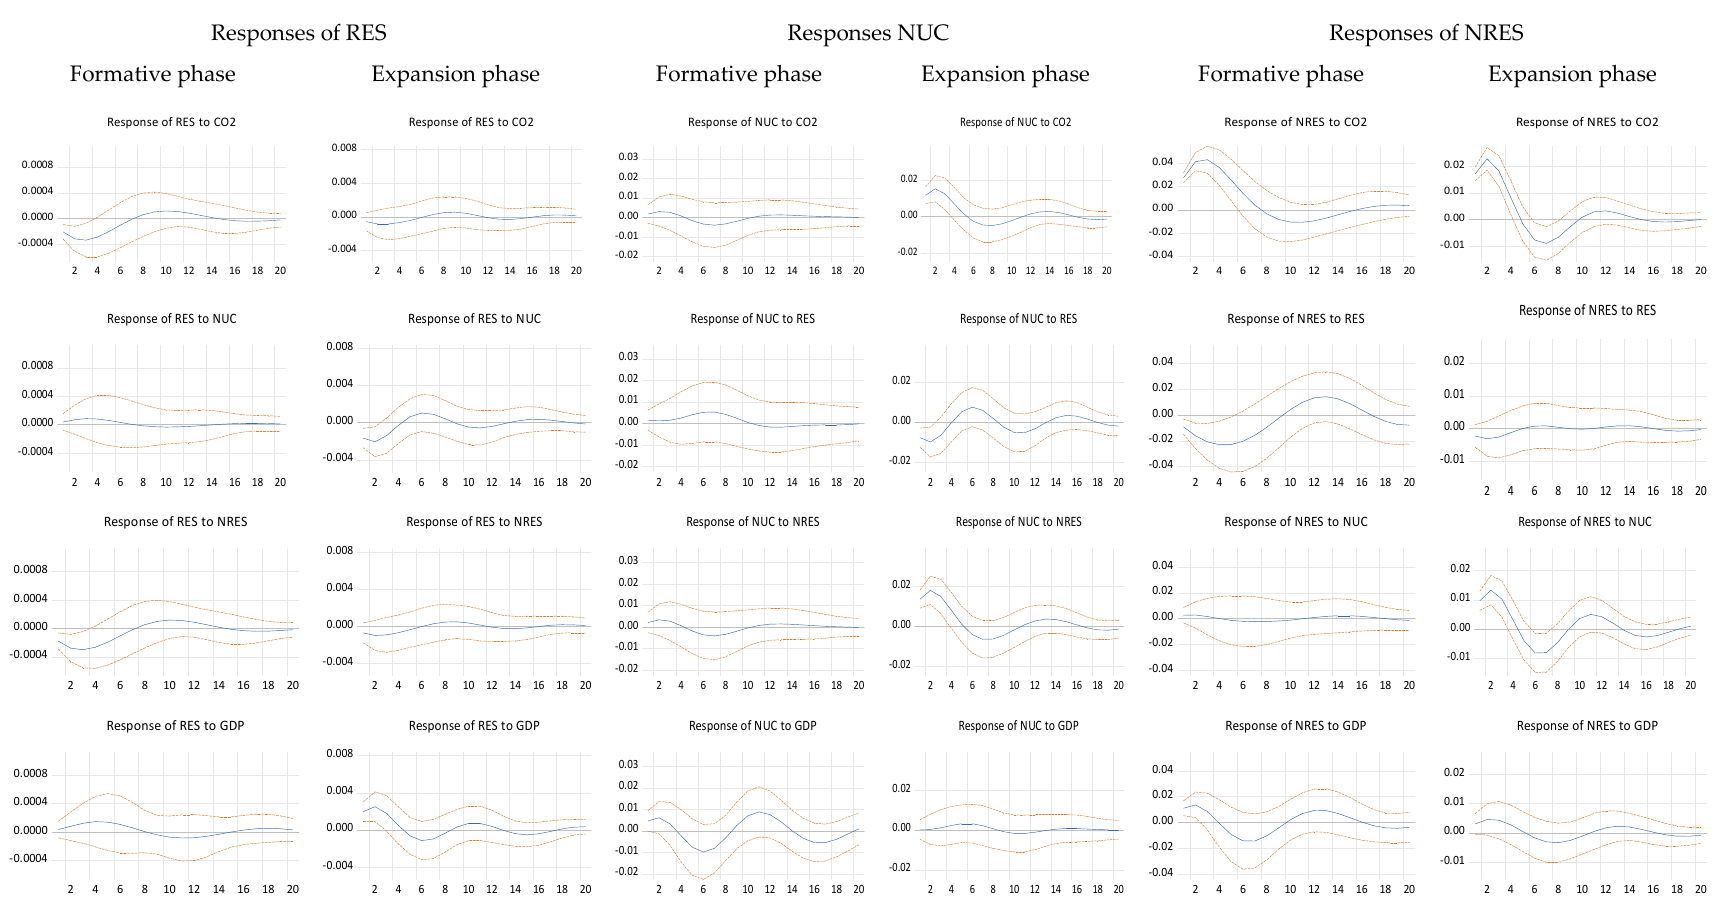
Figure A3. Responses of RES, NUC, and NRES to shocks in variables in the formative and expansion phases in Sweden.